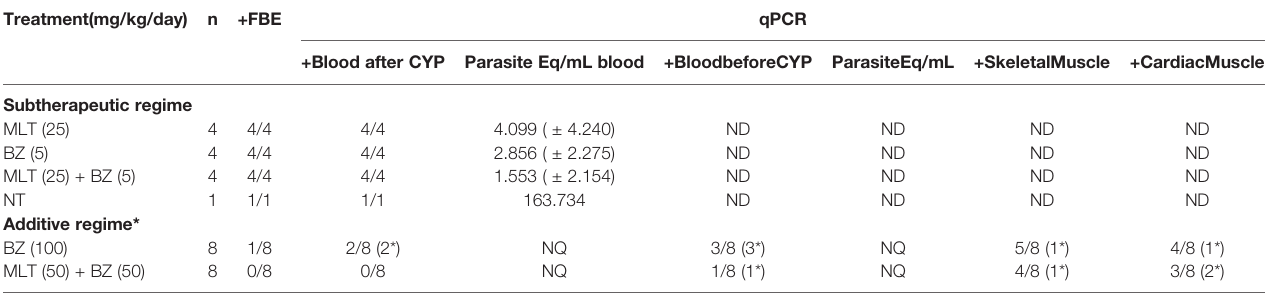
TABLE 5 | Effect of miltefosine alone or combined with benznidazole at different sub-therapeutic or additive regimes on parasite burden at the end of the treatment in BALB/cJ mice infected with Trypanosoma cruzi (VD strain). Treatment(mg/kg/day) n